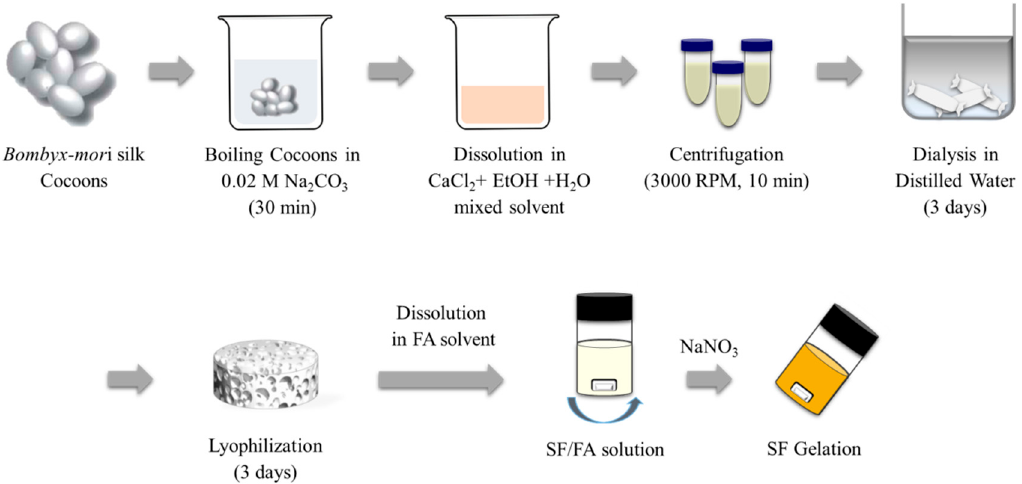
Figure 10. Scheme of SF gelation process using regenerated SF. RPM represents rotation per minute.